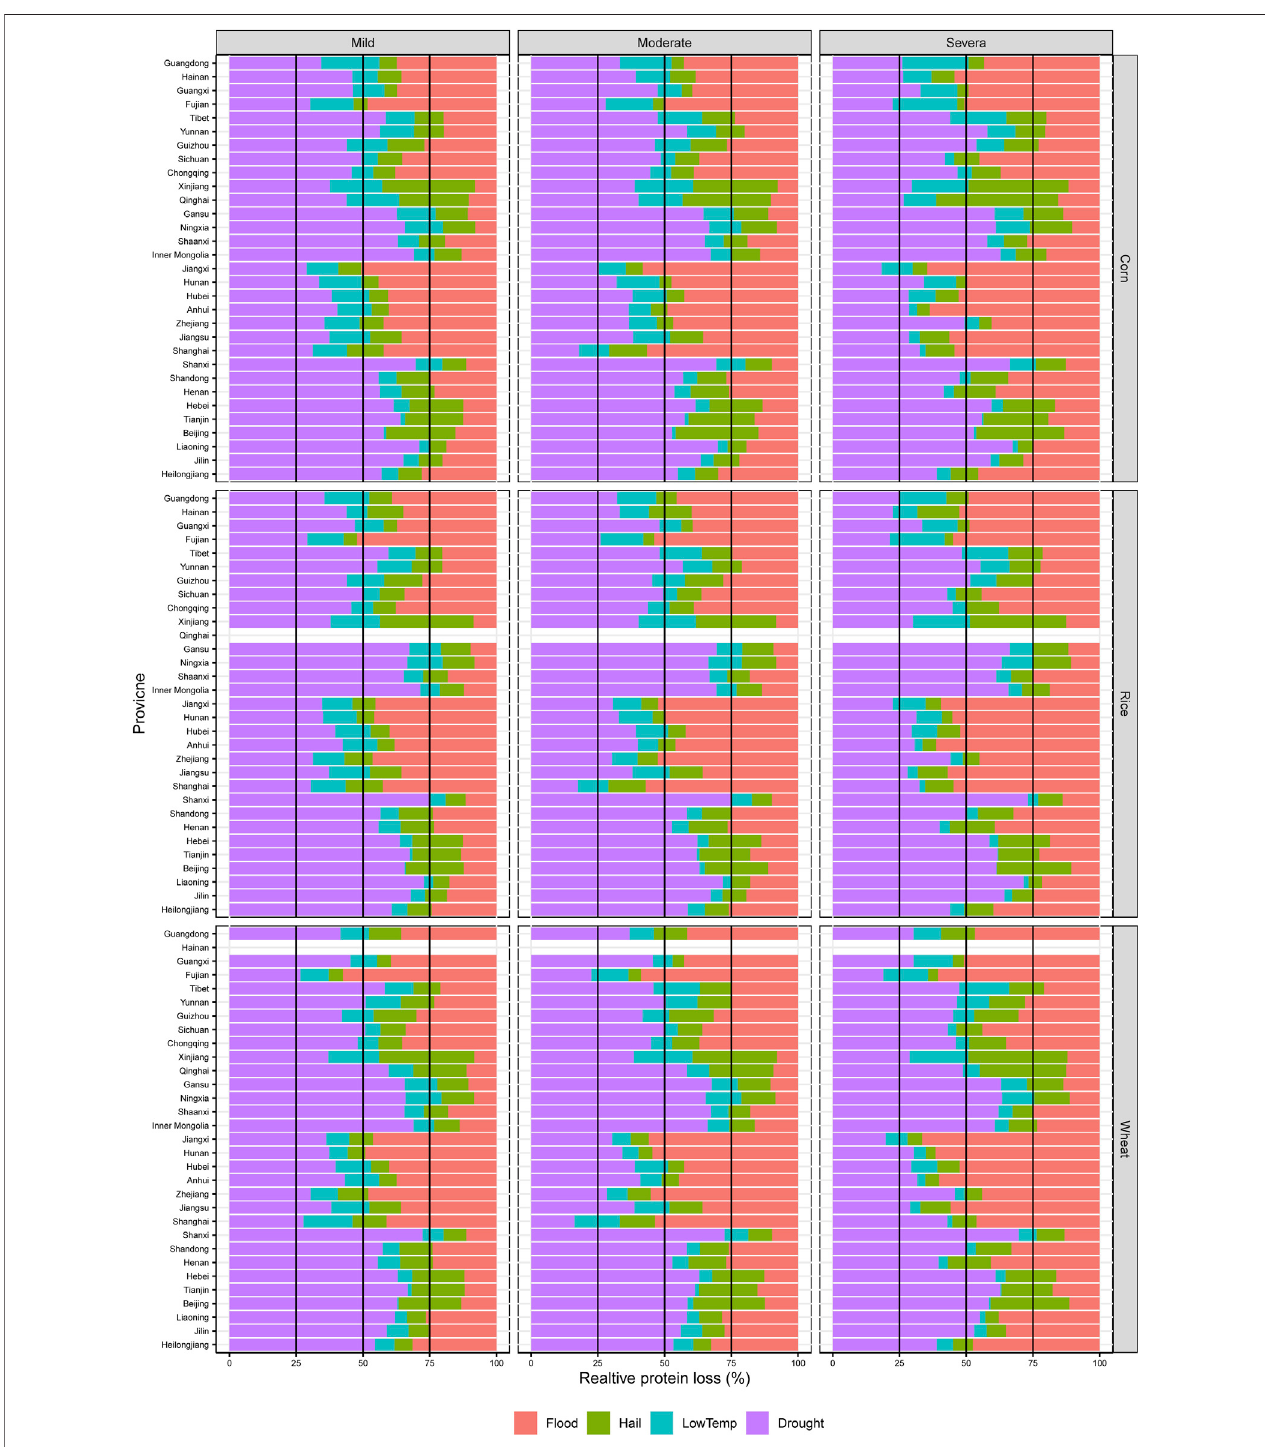
FIGURE12| Cumulativerelativeproteinlossduetodifferentnaturaldisastersfrom1988to2020foreachprovince.Theverticallinerepresentsthe25,50,and75% contribution to the total loss, respectively. Due to the high protein losses from drought and fl ood, if the bar for drought or fl ood overlaps with the vertical lines, more than 50% of the protein loss was caused by that type of disaster.